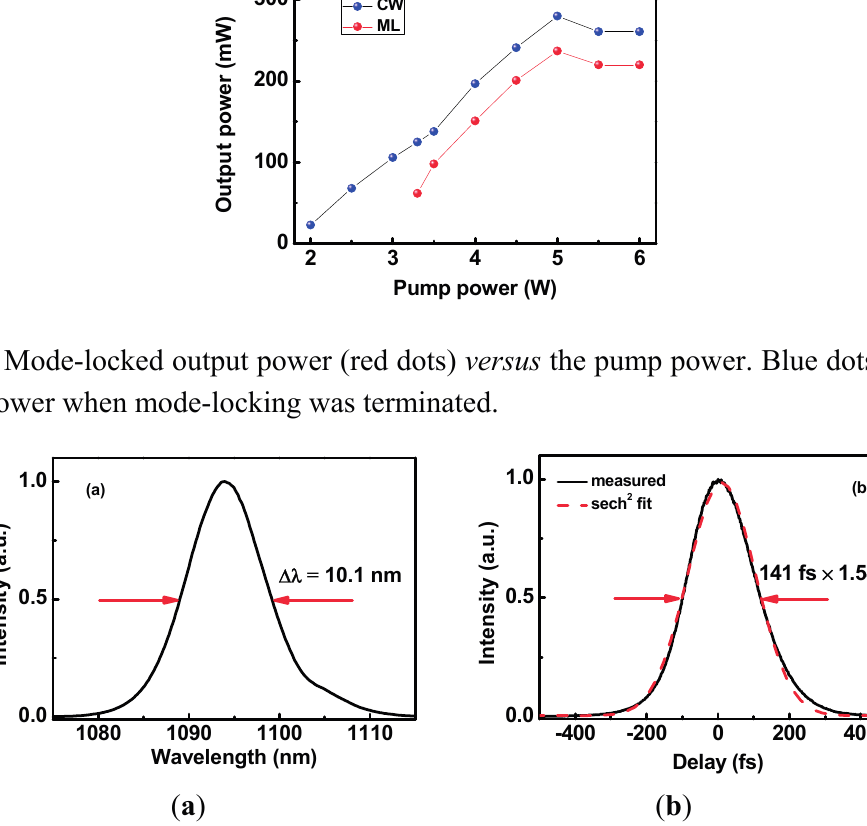
Figure 5. ( a ) Spectrum of the femtosecond pulses centered at 1094 nm; ( b ) Autocorrelation trace of the femtosecond pulses (black curve) and the sech 2 -fitting curve (red dashed